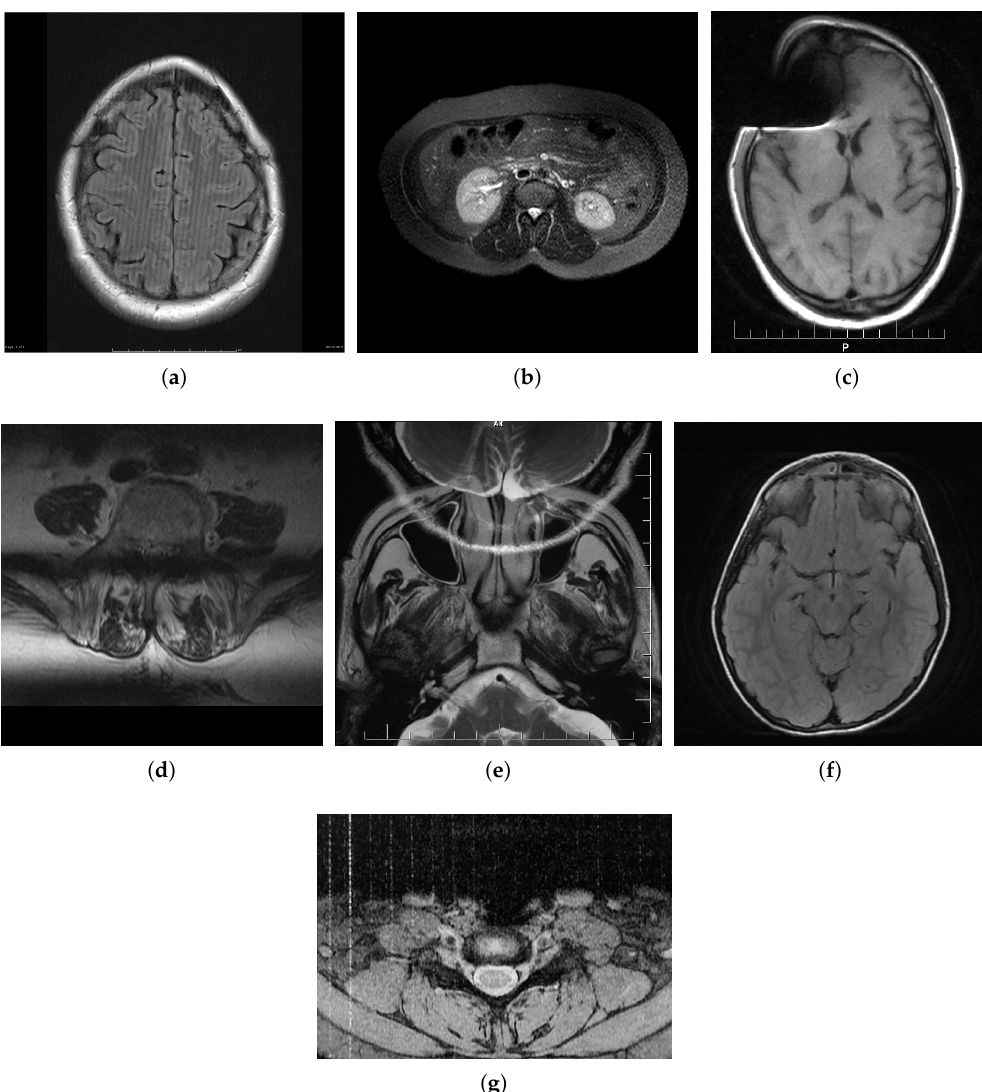
Figure 1. Examples of artifacts in MR images: ( a ) herringbone; ( b ) ghosting; ( c ) magnetic suscep- tibility; ( d ) slice overlap; ( e ) aliasing; ( f ) Gibbs effect; and ( g ) zipper. Cases were the courtesy of: ( a ) Assoc. Prof. Frank Gaillard, rID: 19695; ( b ) Assis. Prof. Faeze Salahshour, rID: 81727; ( c ) Dr. Ayush Goel, rID: 22731; ( d ) Dr. Roberto Schubert, rID: 16705; ( e ) Dr. Prashant Mudgal, rID: 26927; ( f ) Dr. Prashant Mudgal, rID: 27302; and ( g ) Dr. Alan Nazerian, rID: 45665; radiopaedia.org (accessed on 27 April